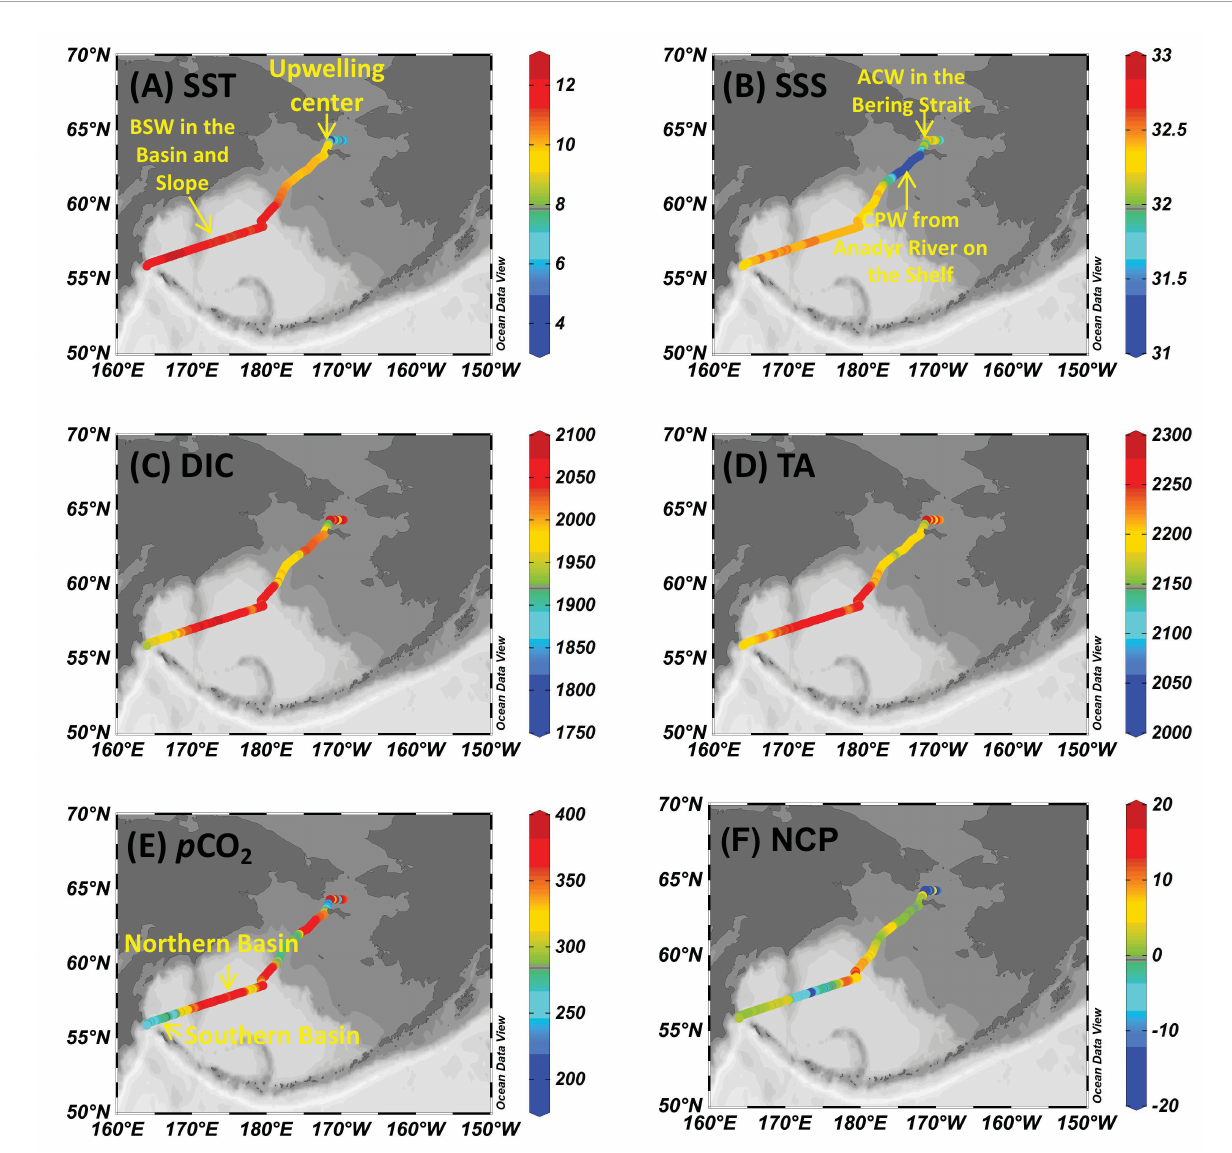
FIGURE 5 Sea surface distribution of (A) temperature, SST (°C), (B) salinity, SSS, (C) dissolved inorganic carbon, DIC (µmol kg -1 ), (D) total alkalinity, TA (µmol kg -1 ), (E) partial pressure of CO 2 , p CO 2 (µatm), and (F) net community production, NCP (mmol C m -2 d -1 ) during the return voyage in